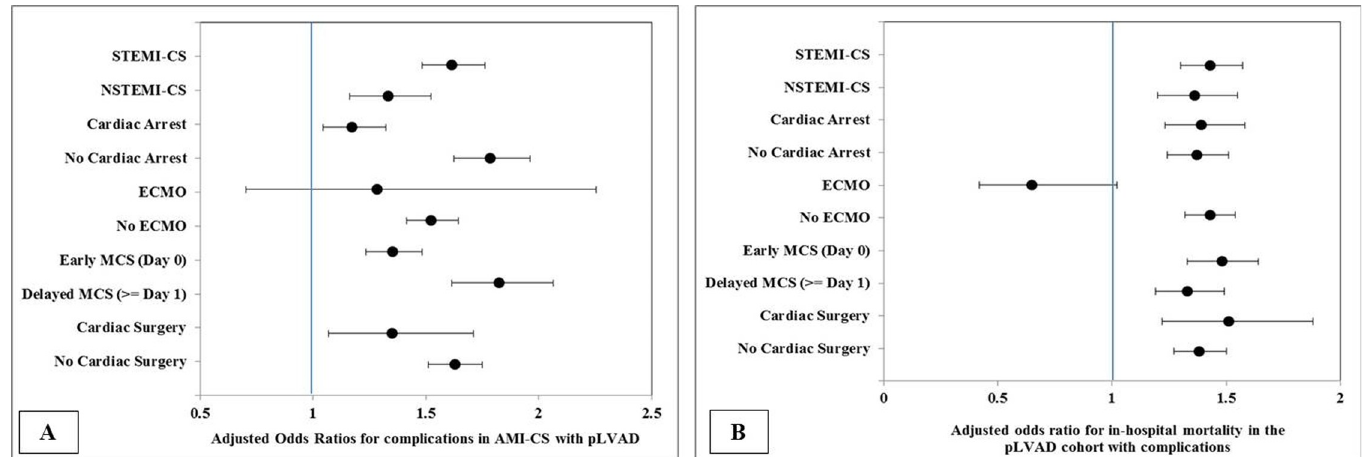
Fig 4. Multivariate predictors of complications and in-hospital mortality in the complications cohorts of AMI-CS supported with pLVAD compared to the IABP. Multivariable adjusted odds ratios (95% confidence intervals) � for occurrence of complications (A) and in-hospital mortality in admissions with complications in AMI-CS supported by pLVAD compared to IABP; all p < 0.001 where 95% confidence interval does not include unity. � Adjusted for age, sex, race, comorbidity, primary payer, socio-economic stratum, hospital characteristics, AMI type, acute organ failure, cardiac arrest, coronary angiography, percutaneous coronary intervention, invasive hemodynamic monitoring; extracorporeal membrane oxygenation use, invasive mechanical ventilation, hemodialysis and receipt of cardiac surgery. Abbreviations: AMI: acute myocardial infarction; CS: cardiogenic shock; ECMO: extracorporeal membrane oxygenation; MCS: mechanical circulatory support; NSTEMI: non-ST-elevation myocardial infarction; STEMI: ST-elevation myocardial